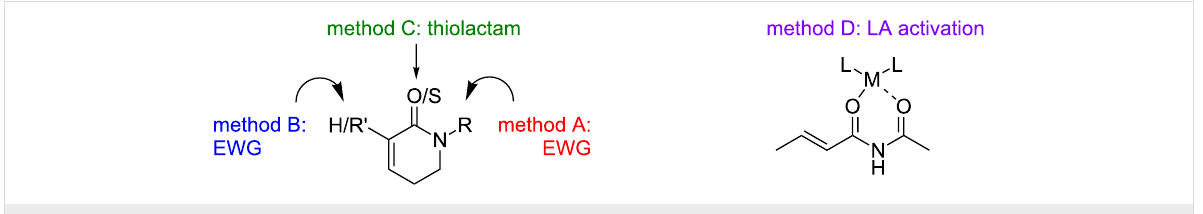
Figure 1: Methods to activate unsaturated amide/lactam systems.